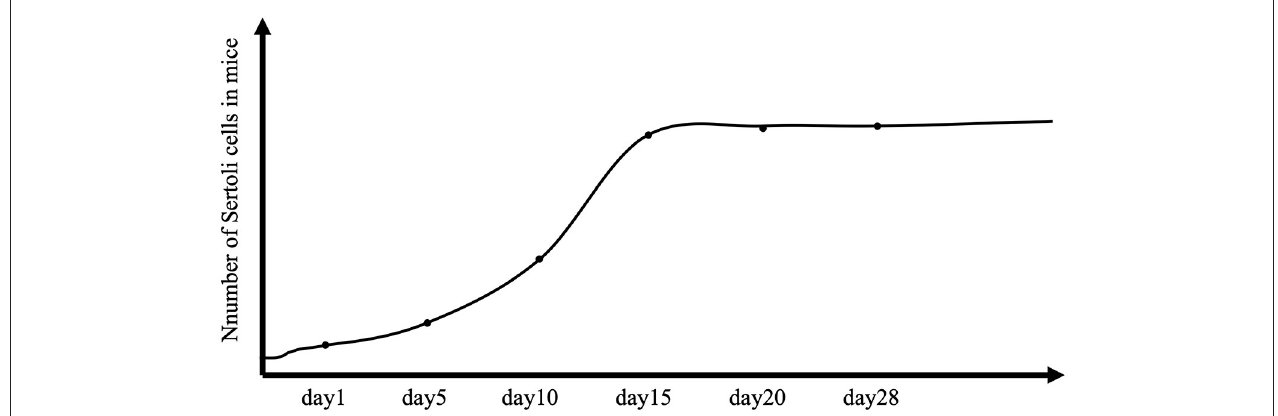
FIGURE 1 | Total number of Sertoli cells per testis in controls. The number of Sertoli cells per testis is considered stable throughout the life of the animal, but in mice, proliferation extends to 2 weeks after birth.